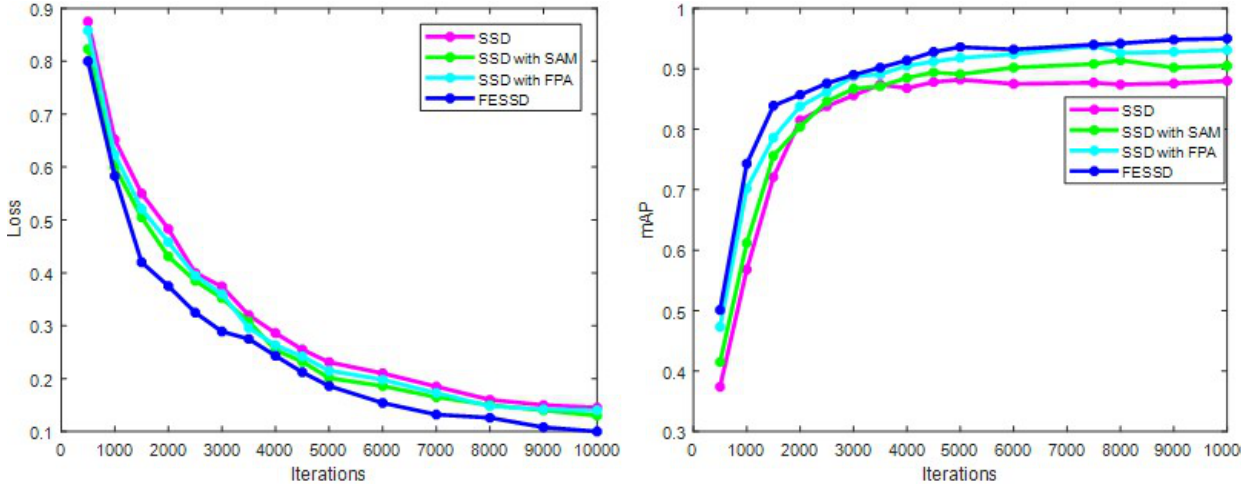
Figure 11. The comparison of loss values and mAP of different attention